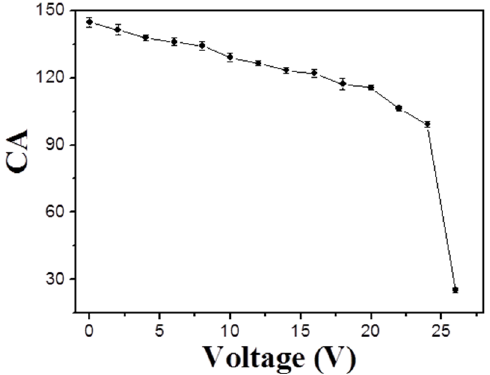
Figure 6. The water contact angle photos of the conductive polymer porous film prepared from the polymer solution of 0.8% at different voltages.